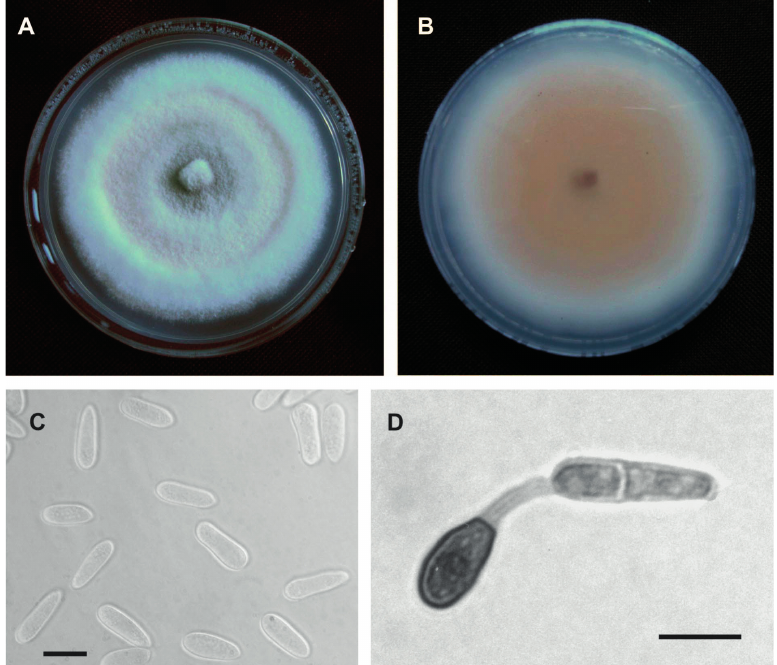
Figure 4. Colony morphology of Colletotrichum clavatum IMI 398854 (ex-type). Plate in front (A) and reverse (B) grown for 14 days on PDA at 24(±1)°C. Light micrographs showing the characteristic clavate conidia (C) and a germinating conidium with a clavate, melanized appressorium at the apex of the germ tube (D). Scale bars = 10 μ